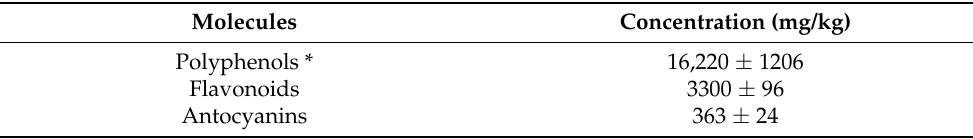
Table 2. Total phenolic content in the